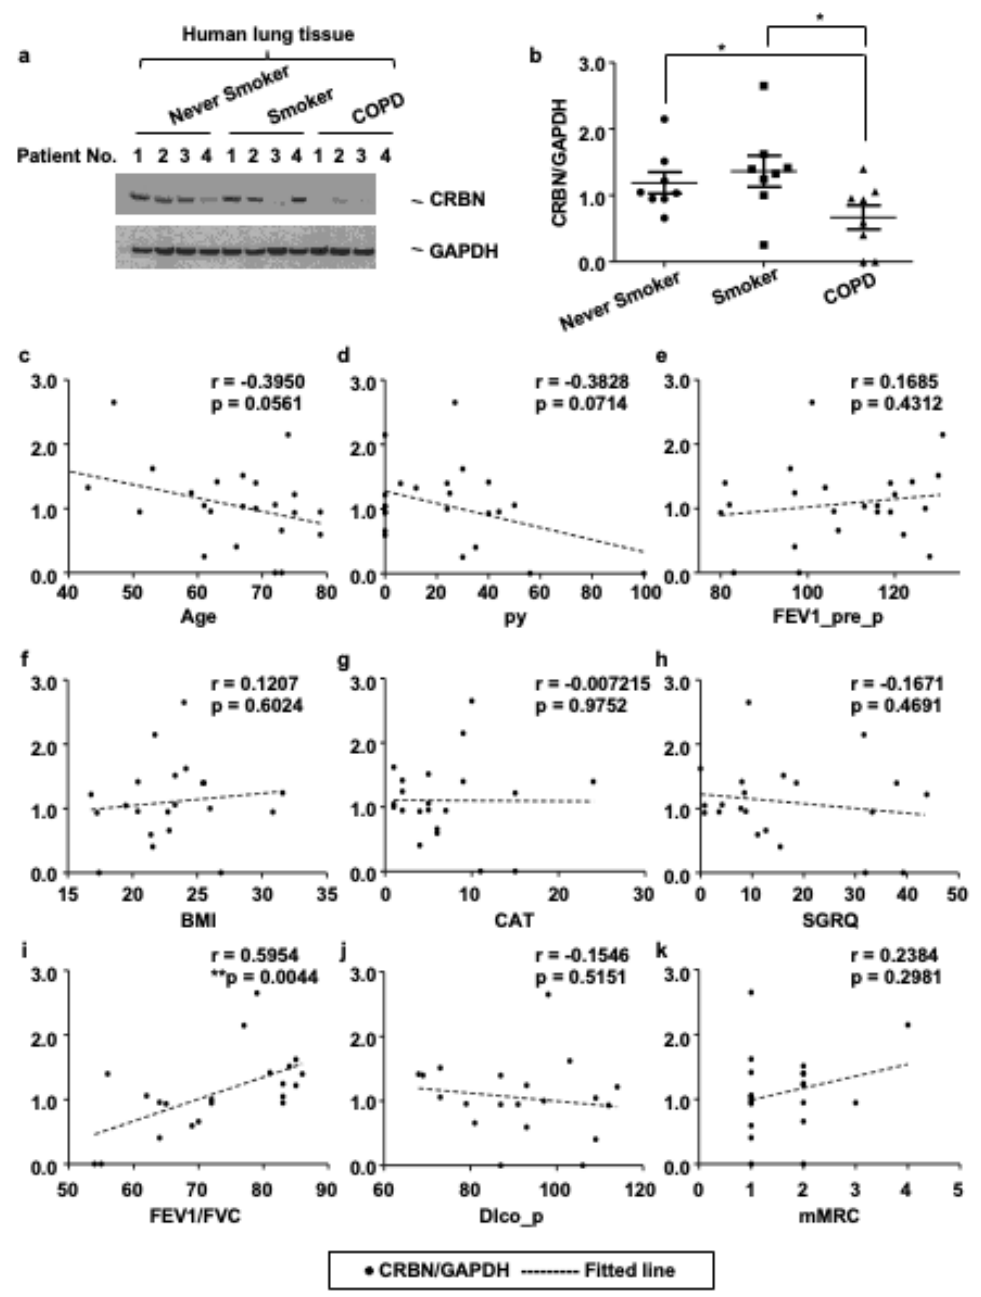
Figure 1. The level of CRBN expression was decreased in lung tissues of patients with COPD and correlated with the FEV1/FVC ratio. ( a ) Lung homogenates from never smokers (n = 8), smokers (n = 8), and patients with COPD (n = 8) were subjected to Western blot analysis for CRBN and GAPDH. ( b ) Gel data were quantified using Scion image densitometry. Data represent the mean ± SE. * p < 0.05, ** p < 0.01. ( c - k ) Pearson correlation coefficient, r, was calculated for the expression level of CRBN ( y -axis) and clinical parameters ( x -axis) of 24 subjects.